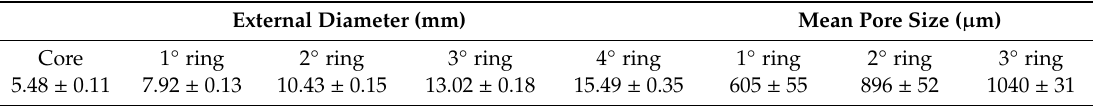
Table 3. Measured diameters of the rings in the lattice part and pore sizes of the FGM bi-layer structures. External Diameter (mm)